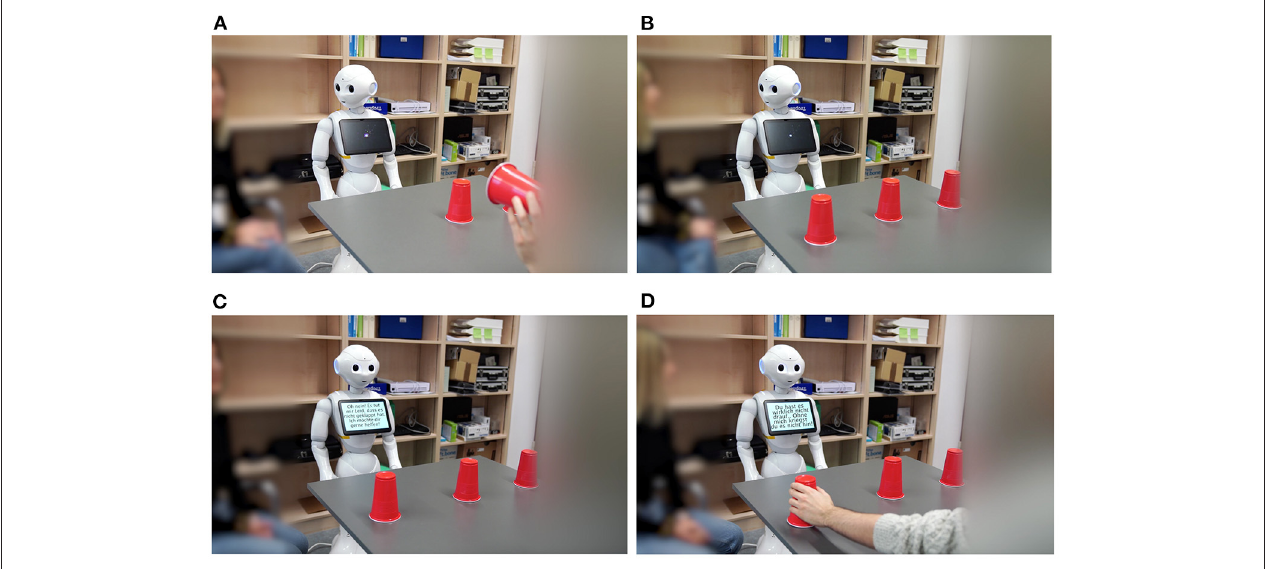
FIGURE 2 | Screenshots of the videos in Study 2, displaying HRI during a shell game in the conditions (A) anthropomorphism high x warmth high, (B) anthropomorphism high x warmth low, (C) anthropomorphism low warmth high, and (D) anthropomorphism low warmth low.